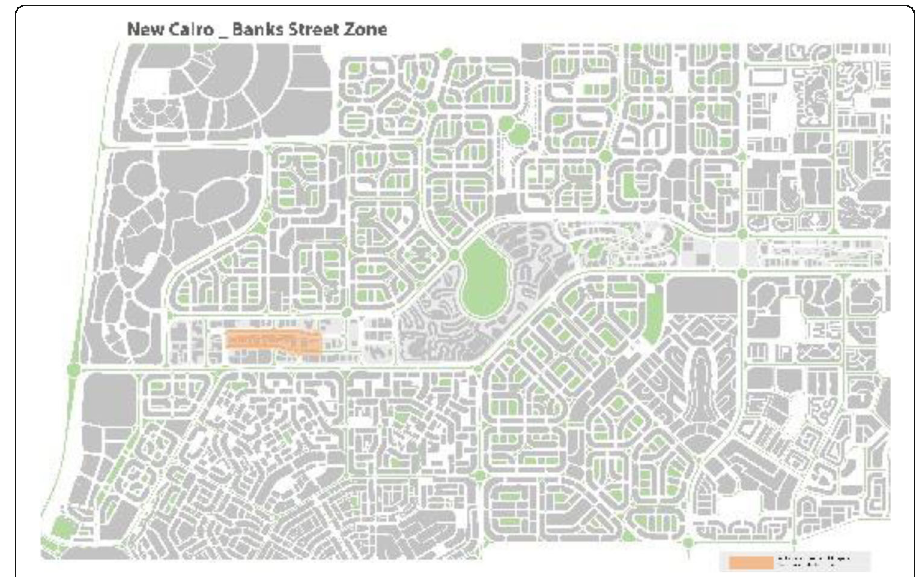
Fig. 10 New Cairo map, and the selected Banks street public space (Author)